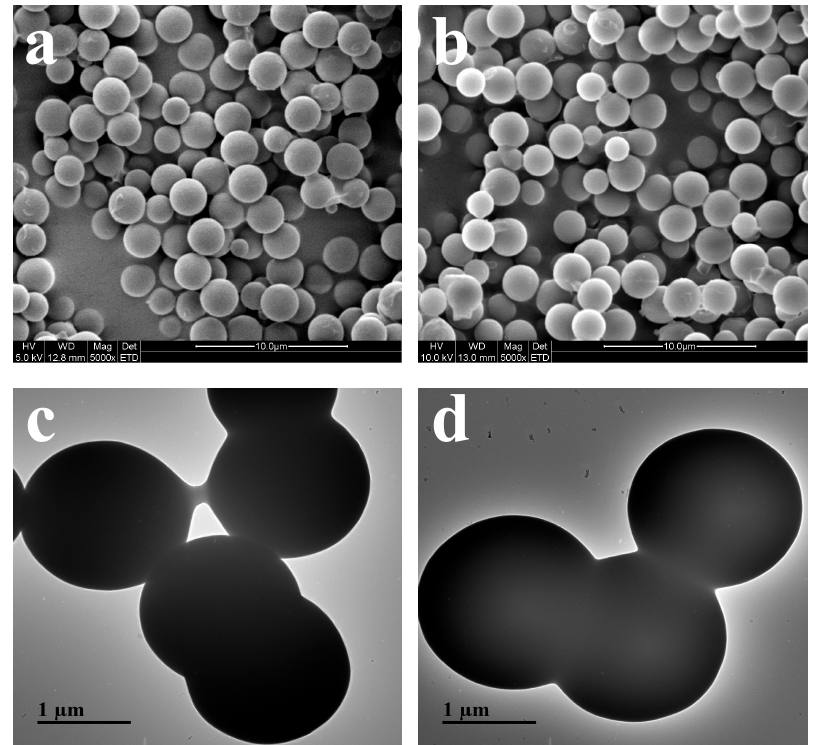
Figure 3. The scanning electron microscopy (SEM) and transmission electron microcopy (TEM) images. ( a ) SEM of the imprinted polymer containing the template (MIPT); ( b ) SEM of molecularly imprinted polymer (MIP); ( c ) TEM of MIPT; ( d ) TEM of MIP.